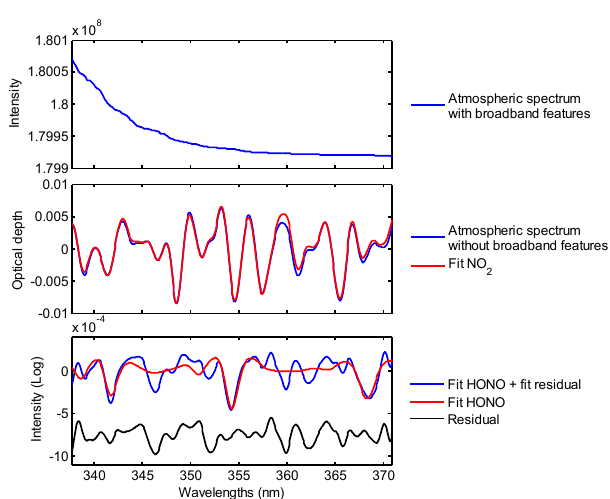
Figure 2. Result of a DOAS analysis of HONO and NO 2 of a spec- trum measured on 2 February 2012, 02:43 mountain standard time (MST). (a) Atmospheric spectrum with broadband features mea- sured on the upper light path. (b) NO 2 fit result (red line) super- imposed on the atmospheric spectrum without broadband features (blue line). (c) Fit result for HONO (red line) superimposed on sum of fitted HONO and unexplained residual structures in the fit (blue line); residual spectrum (black) shifted 7 . 5 × 10 − 4 on the y axis for better comparison with fitted HONO. The retrieved mixing ratio of HONO for this spectrum is 144 ±